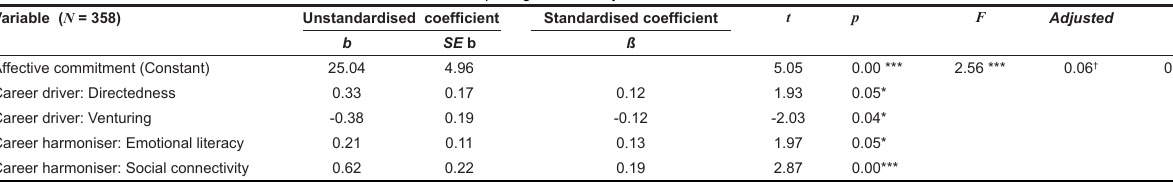
TABLE 3 Multiple regression analyses: PCRI and